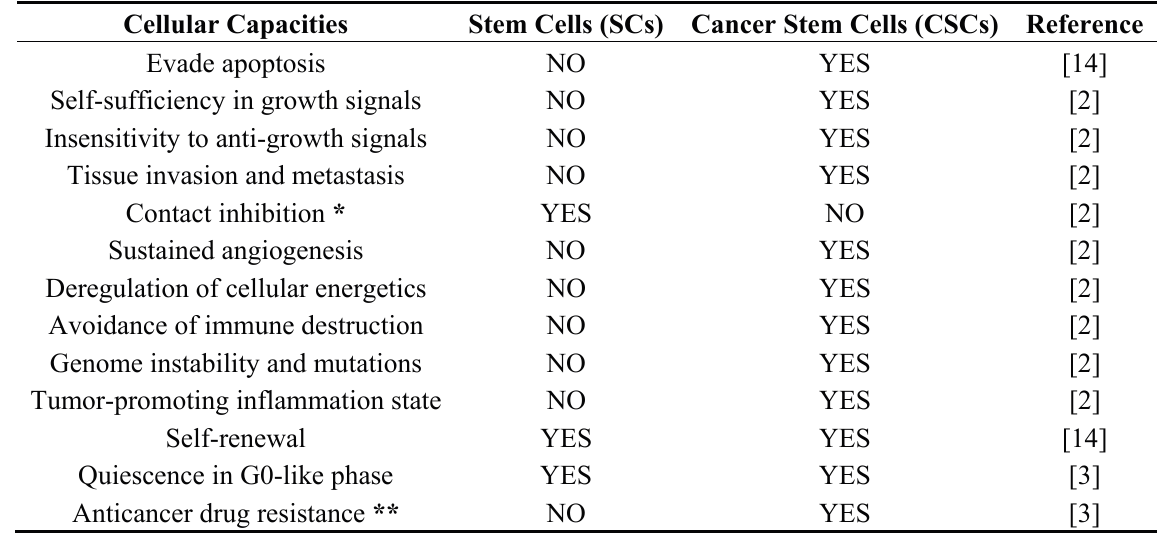
Table 1. Cellular capacities of tissue-specific stem cells (SCs) and cancer stem cells (CSCs). Cellular